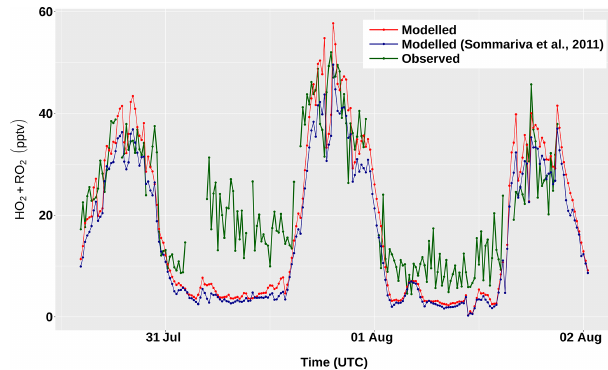
Figure 7. Measured and modelled concentrations of total peroxy radicals (HO 2 + RO 2 ) between 31 July and 2 August, during the TexAQS 2006 cruise of the NOAA research vessel Ronald H. Brown